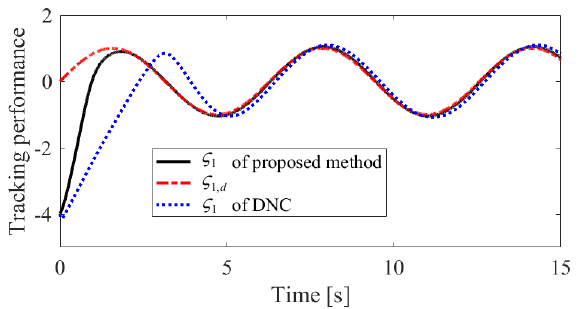
Figure 6. The control input in Case 1.